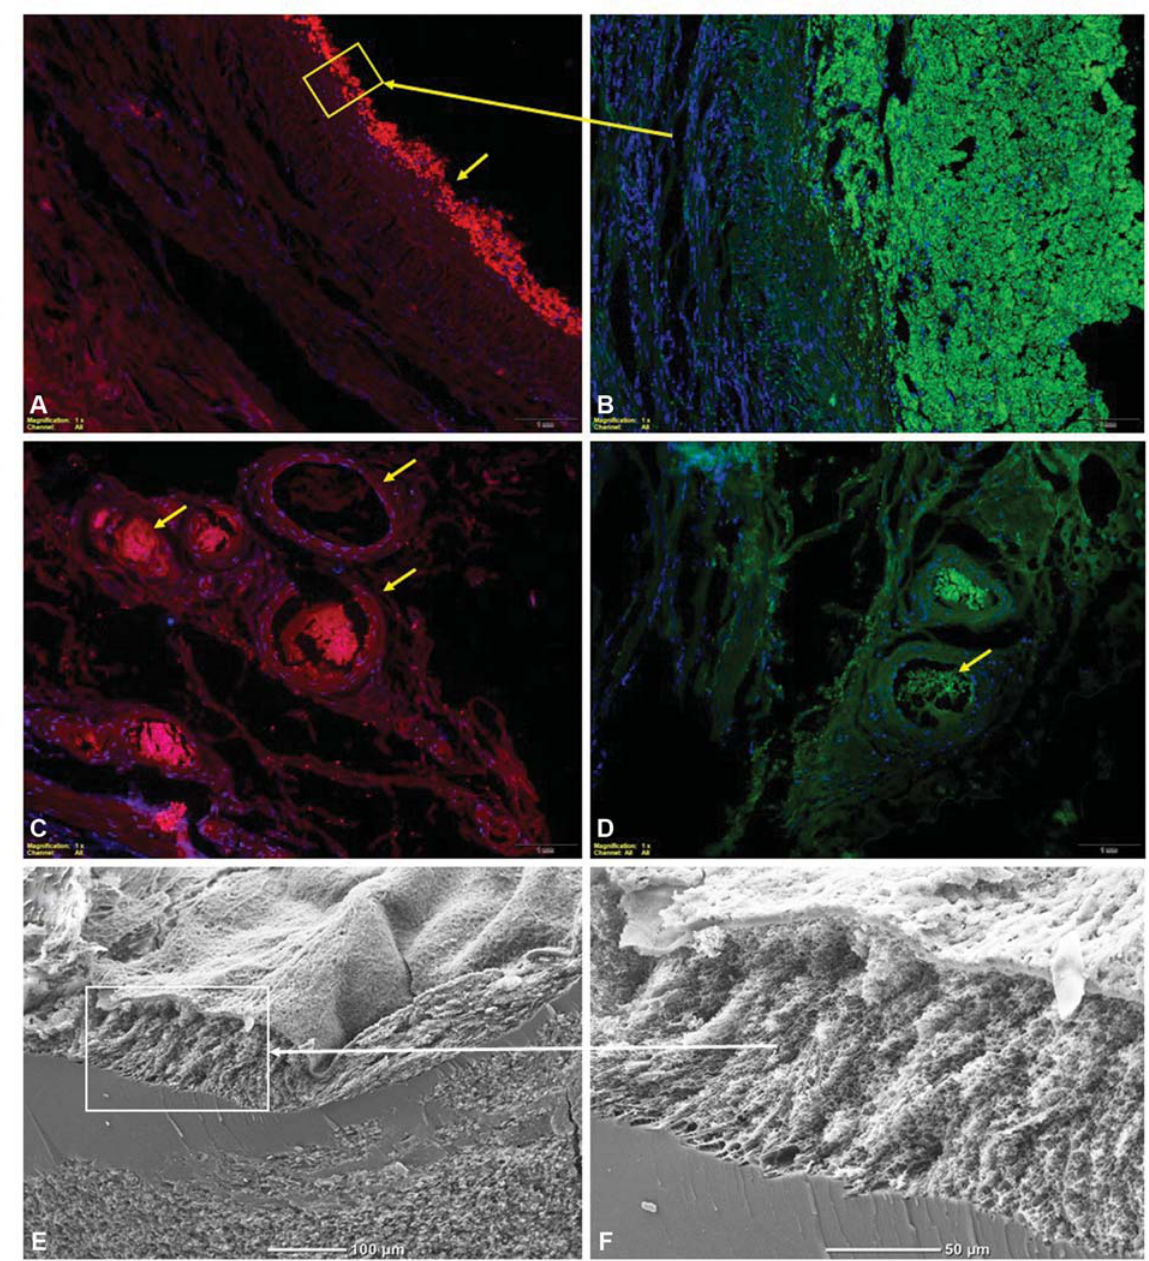
Fig. 1 Representative images of SV graft immunostaining after massive thrombosis ( A – D ) prothrombin stained red, TF stained green, nuclei stained blue using DAPI and scanning electron microscopic images ( E, F ) of the surface of whole blood clot formed in vitro from citrated blood obtained from the patient undergoing CABG. Box and arrow represent magni fi cation of the fragment in the box. Arrows show pertinent stained fragments (see text). CABG, Coronary artery bypass grafting; SV, saphenous veins; TF, tissue